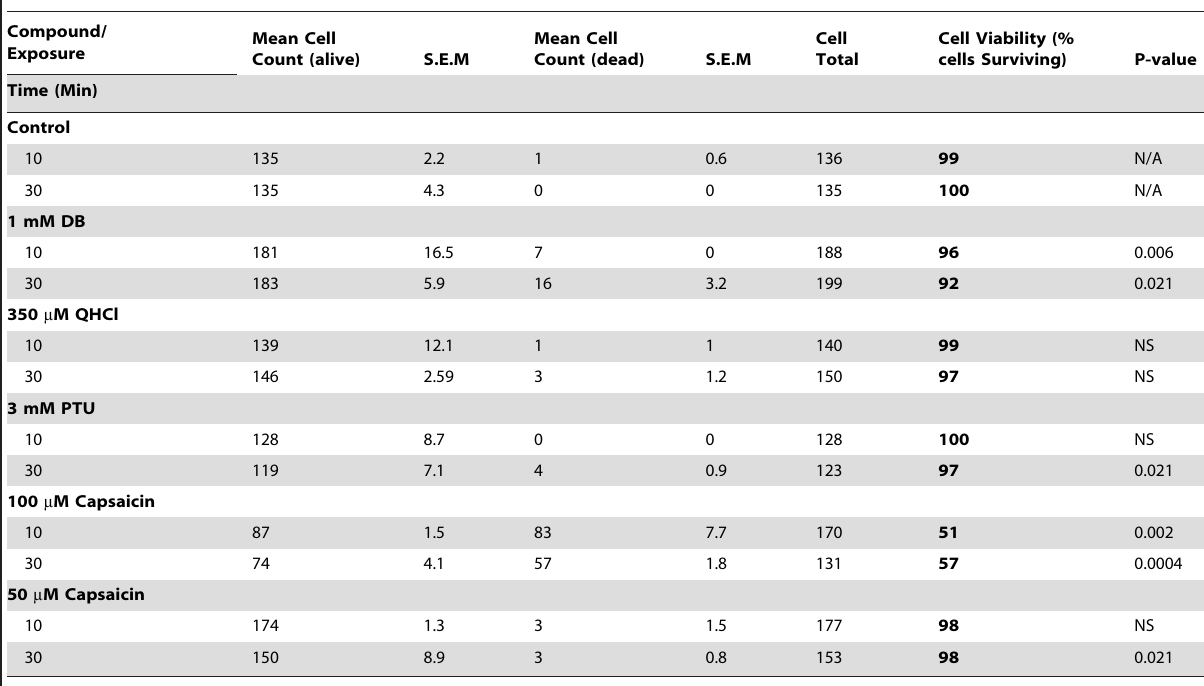
Table 3. Analysis of tastants on Dictyostelium cell viability.